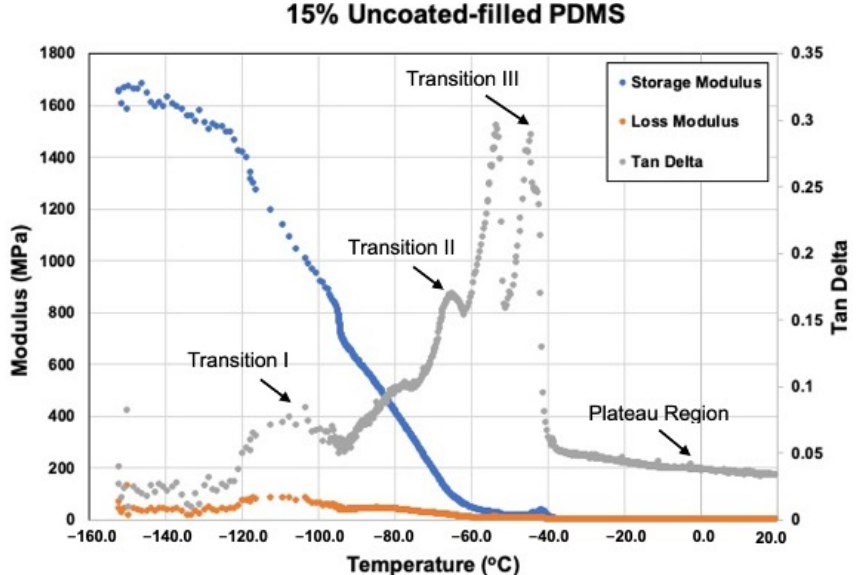
Figure 17. Storage Modulus, Loss Modulus, And Tan Delta Curves For 15% KH220-filled PDMS From ₋ 150 °C To +20 °C.